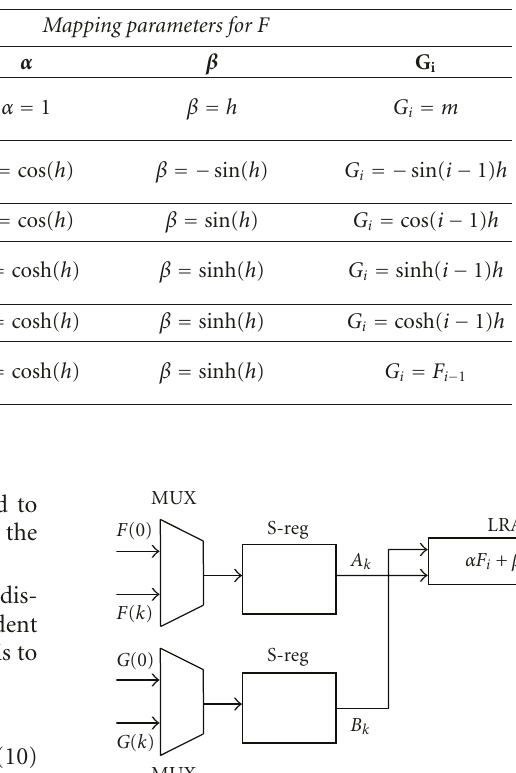
Table 4: Approximation of some usual generic functions by the recursive function F .